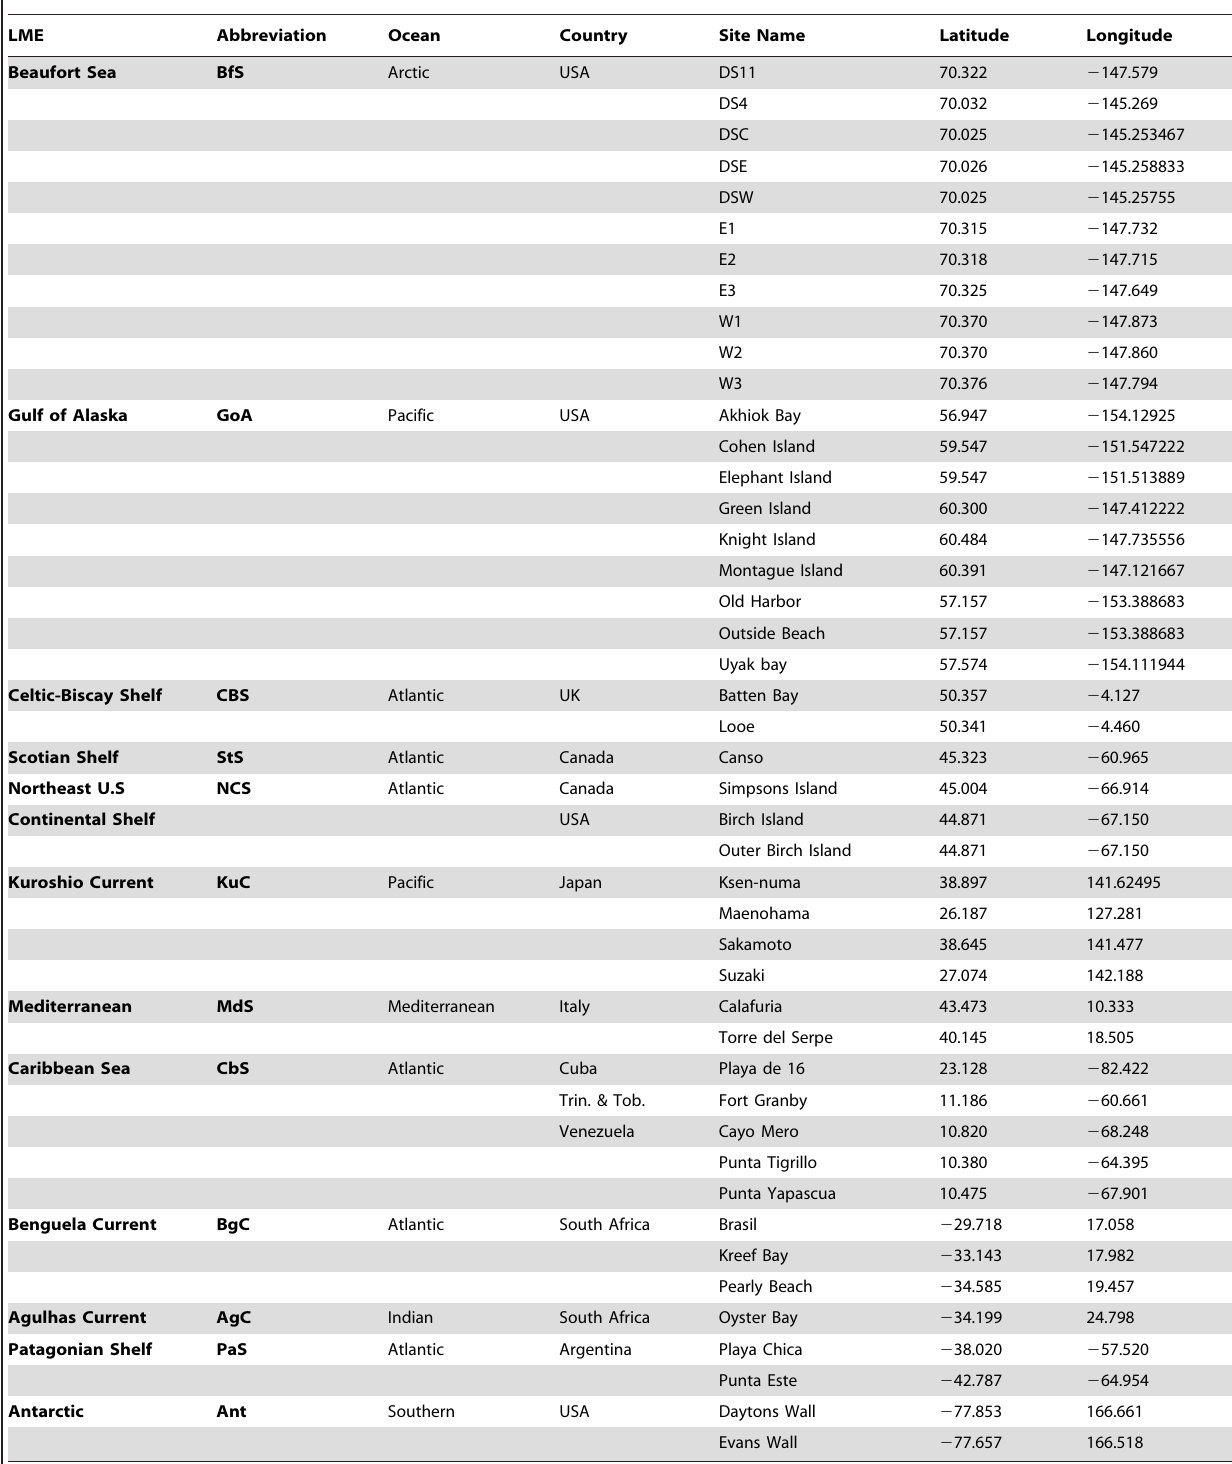
Table 1. Location of the 45 sampled sites in each of the twelve